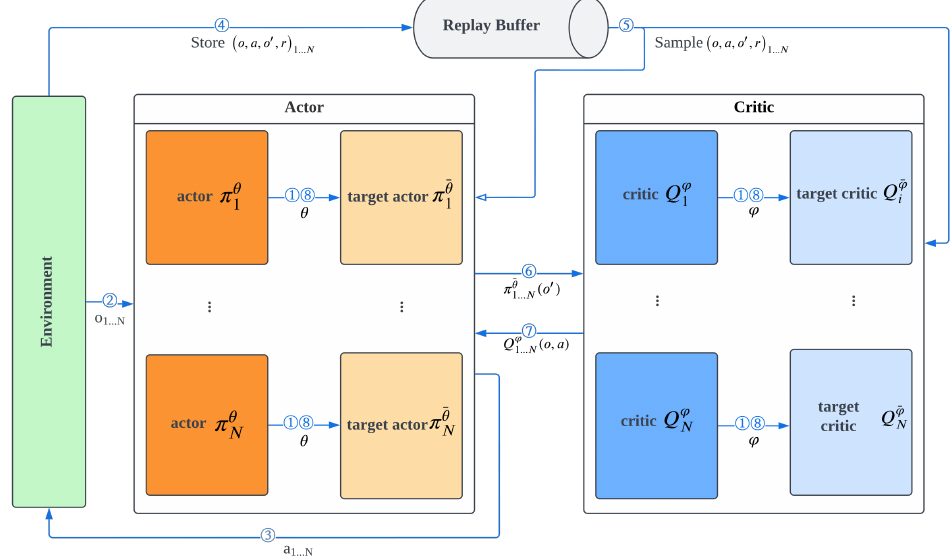
Figure 4. F-MAAC model’s overall architecture with training